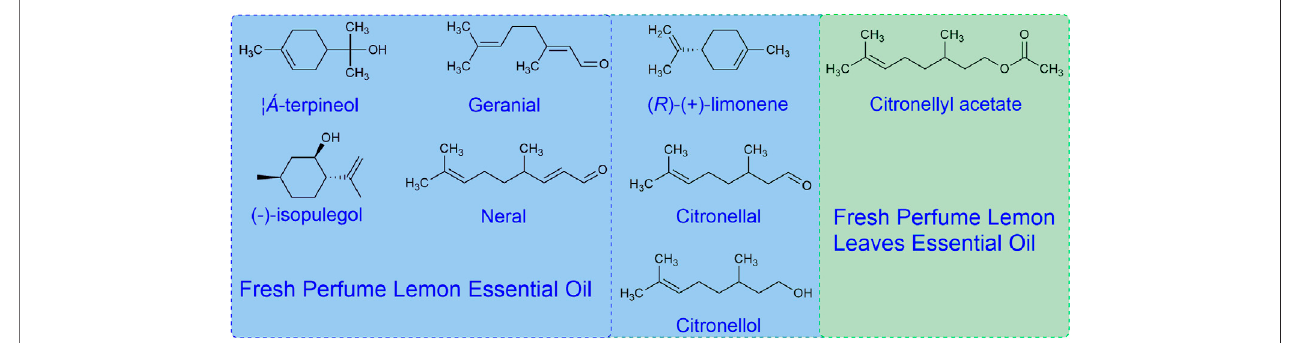
FIGURE 3 | Chemical structures of major components in the two essential oils.